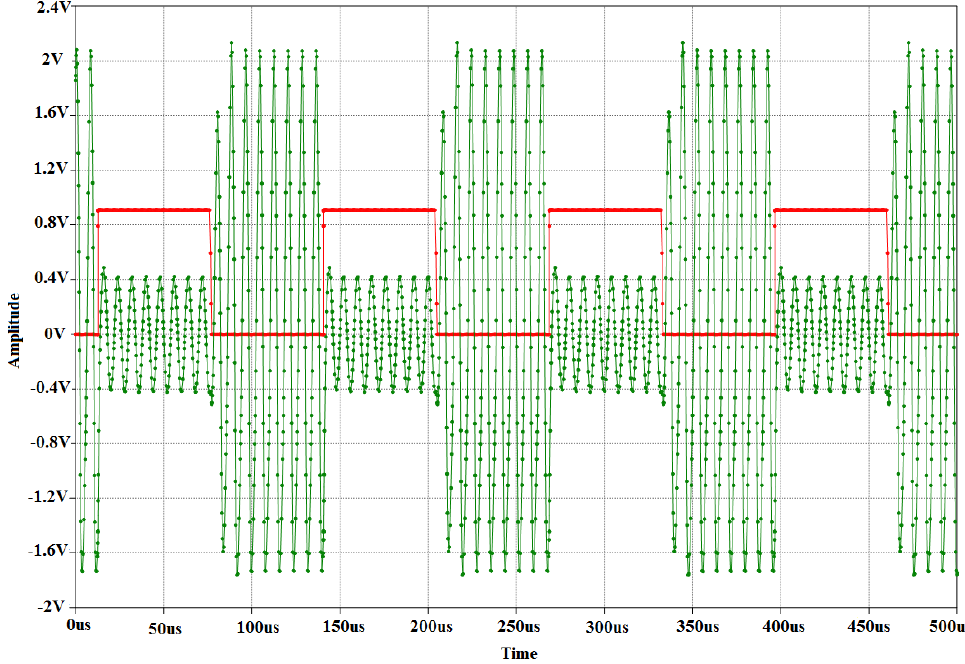
Figure 6. The transient analysis of the load modulator simulation.